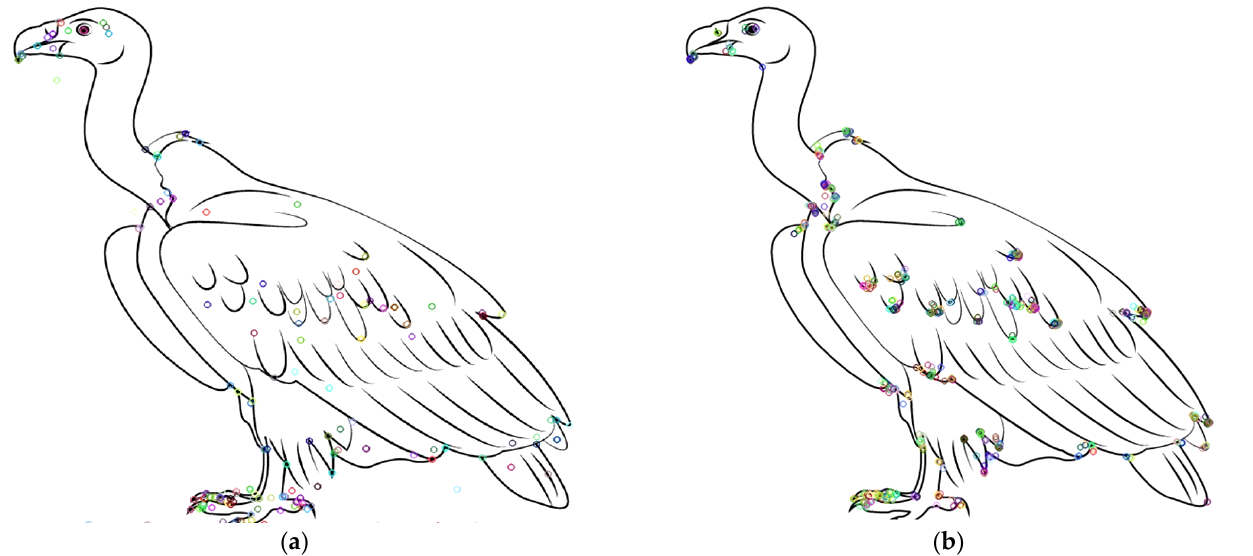
Figure 8. Extracted keypoints using ( a ) SIFT and ( b ) ORB [42].